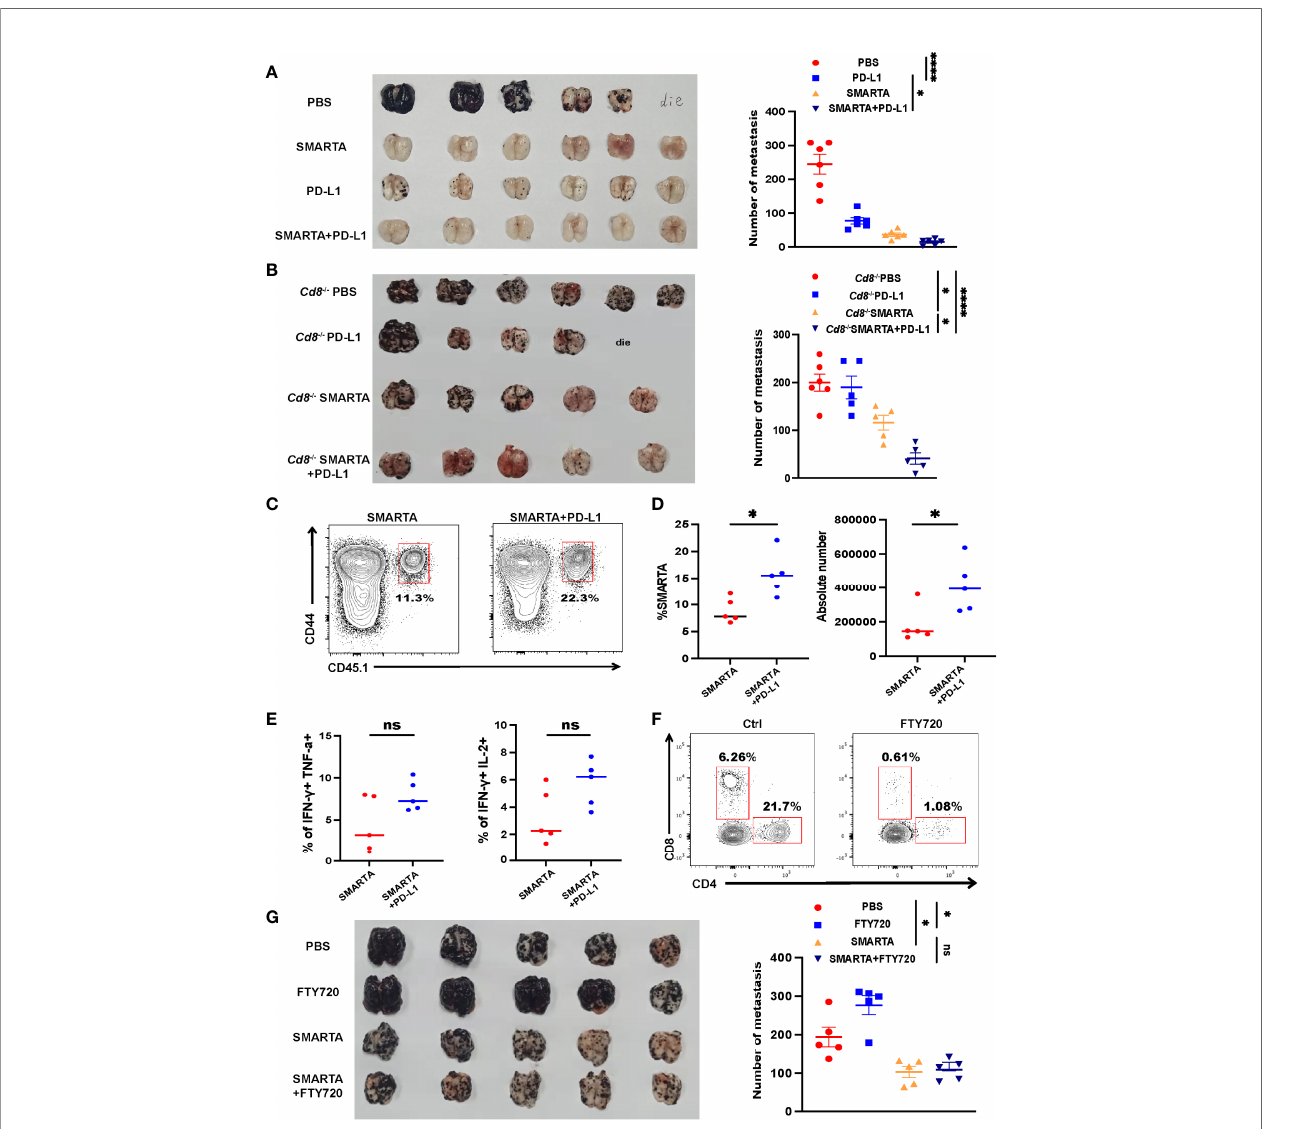
FIGURE 5 | Tumor-speci fi c CD4 + T cells have a synergistic therapeutic effect with PD-L1 blockade. (A) Representative image of lung samples harvested from tumor-bearing C57BL/6J mice (n=6/group) which were treated with 2 × 10 6 activated SMARTA cells or PD-L1 blockade therapy alone or the two combined and sacri fi ced on Day 7 post transfer (endpoint). In PBS-treated group, a mouse died before the endpoint and metastatic foci on the mouse lung was calculated as the same value as the most severe one (similarly hereinafter). The numbers of the metastatic foci are summarized beside. (B) Representative image of lung samples harvested from tumor-bearing Cd8 – / – mice which were treated with PBS (n=6) or PD-L1 monoclonal antibody (n=5) or SMARTA cells alone (n=5) or in combination (n=5) on Day 8 post tumor inoculation and were sacri fi ced on Day 15. In PD-L1 blockade-treated group, a mouse died before the endpoint. The statistical analysis of the metastatic foci is shown beside. (C – E) Flow cytometry analysis of transferred CD45.1 + CD44 + SMARTA cells in Cd8 – / – mice with or without PD-L1 blockade therapy. The frequencies and absolute numbers of SMARTA cells (D) and the statistical analysis of cytokine production of SMARTA cells (E) in the two groups. (F, G) Tumor-bearing C57BL/6J mice (n=5/group) were transferred with SMARTA cells or PBS on Day 8 post tumor challenge, followed by three doses of FTY720 (25 µg intraperitoneal injection) or PBS treatment from Day 9 to Day 15. Representative fl ow cytometry plots of CD4 + and CD8 + T cells in the metastatic lung tissue after FTY-720 treatment analyzing the blocking ef fi cacy of FTY-720 (F) . The image of lung tissue harvested from mice of indicated groups with the statistical analysis of the metastatic foci shown beside (G) . Statistical differences are calculated by one-way ANOVA (A, B, and G, number of metastasis), unpaired t test (D, E). ns, not signi fi cant, * p < 0.05, **** p <